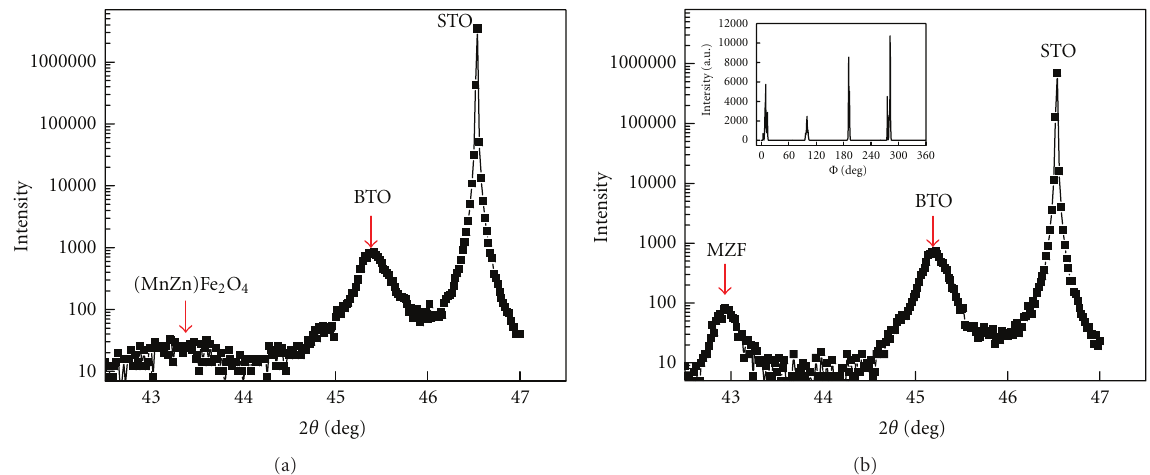
Figure 1: (00 l ) line scans of BTO-MZF thin films by HRXRD, (a) as-deposited and (b) after annealed at 1020 ◦ C for one hour. The insert shows the (110) pole figure of the annealed sample.